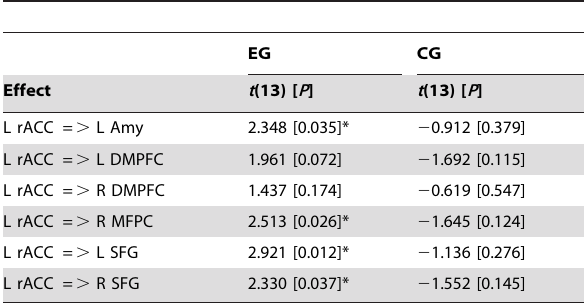
The table contains linear trend t -statistics for the VAR path coefficients across the neurofeedback runs (RE…R3) with the corresponding group P -values. Each data row corresponds to a subplot in Fig. 4. Notations are the same as in Fig. 4. *indicate significant